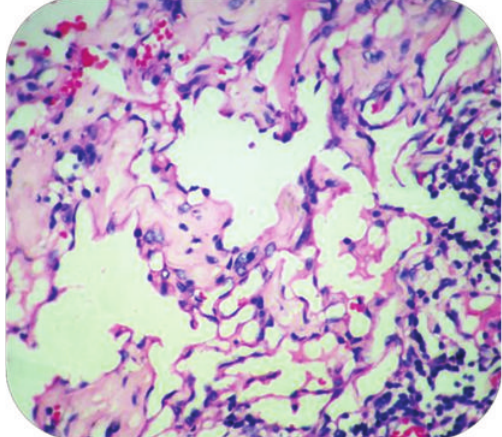
Figure 3: Vascular channels lined by flattened to cuboidal cells. Lymphocytes and RBCs are seen within and outside the lumen (Case 1—H&E × 400).